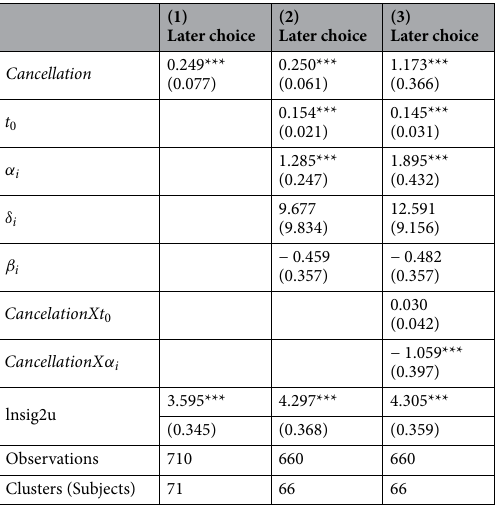
Table 2. Logit regression for Experiment 2 (gains): later choice as dependent variable. Standard errors in parentheses. * p < .10 ; ** p < .05 ; *** p < .01